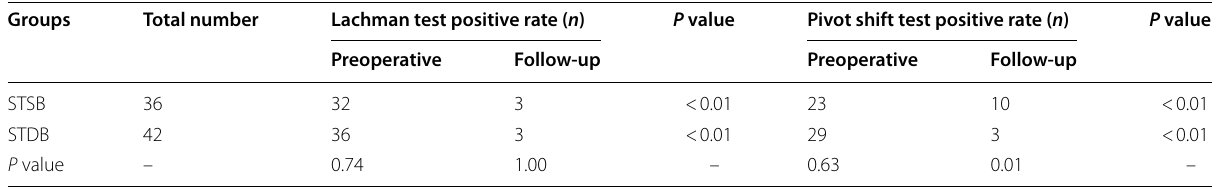
Fisher’s exact test was